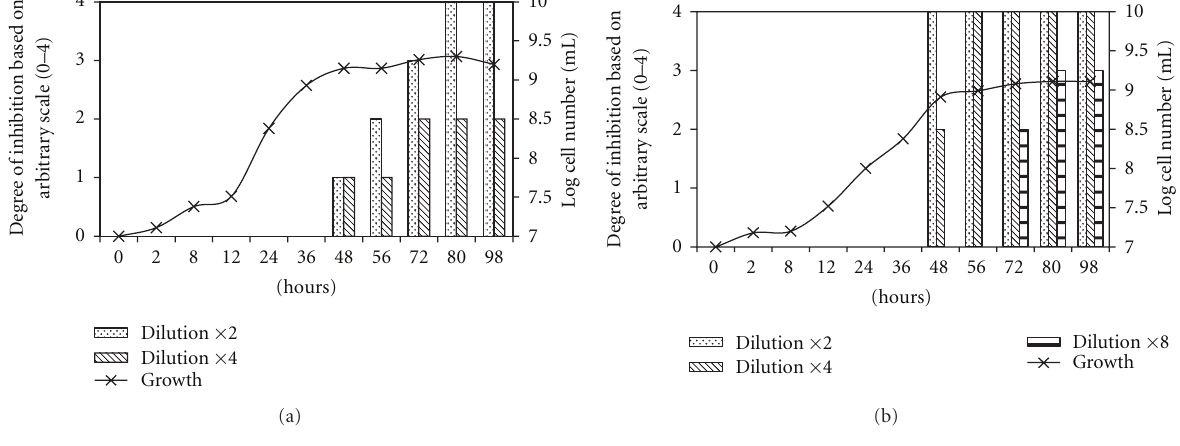
Figure 2: Growth curves and inhibition scores against P. roqueforti for the cell-free supernatant of (a) P. freudenreichii subsp. freudenreichii and (b) P. jensenii . The degree of inhibition showed in the graphs was determined by comparison to control wells and assigned according to the following scale: 0, no inhibition, 1, weak, visible inhibition, 2, obvious inhibition, 3, strong inhibition, but still visible growth and 4, complete